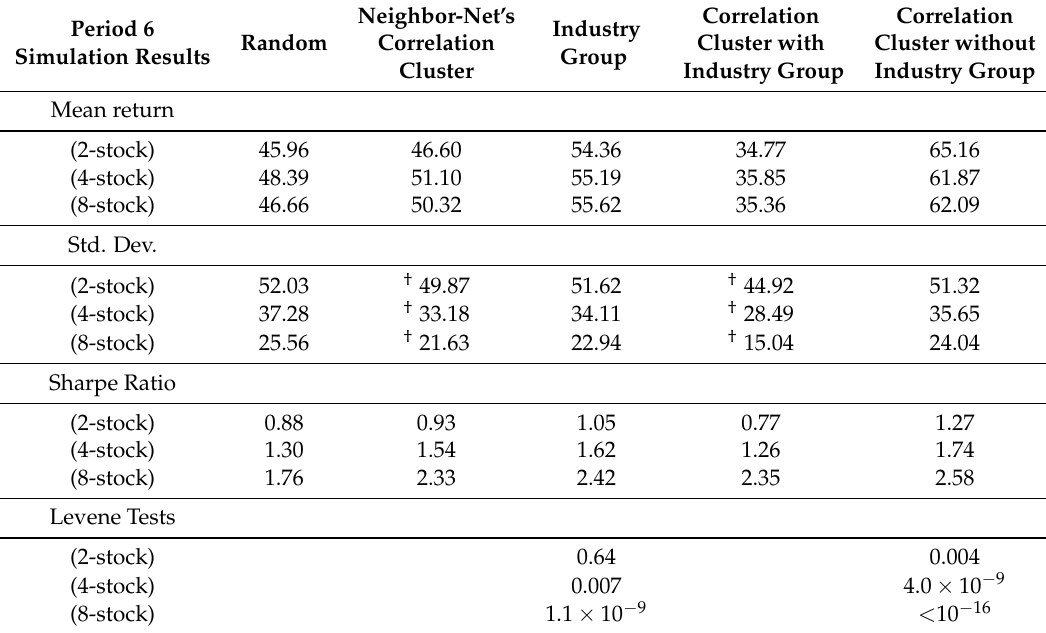
Table 6. Period 6 portfolio performances with standard deviation for three different portfolio sizes. The selection method with the lowest standard deviation is marked with an dagger ( †